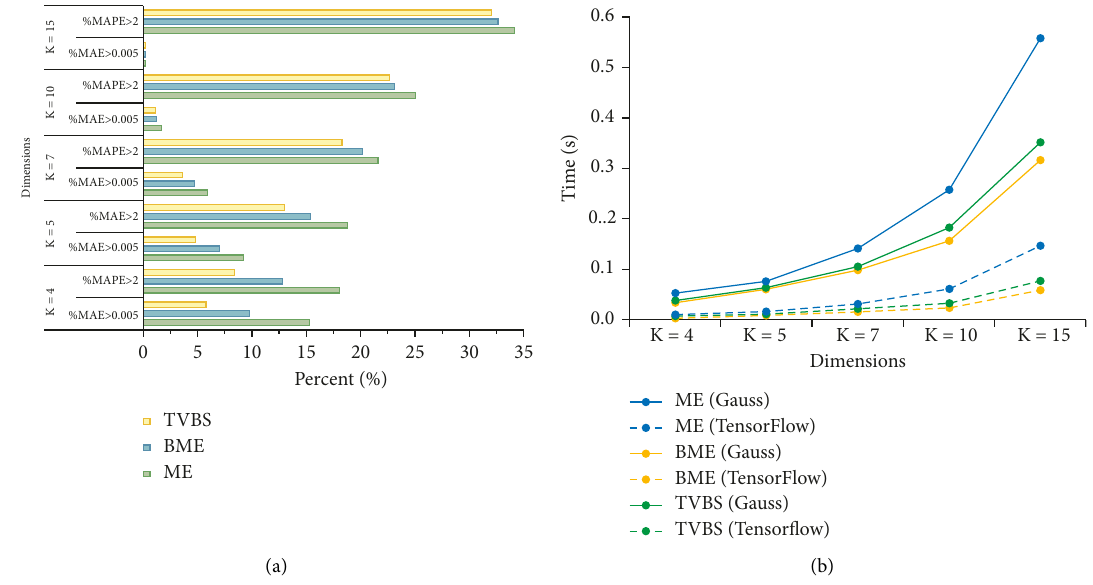
Figure 4: Comparison of accuracy and time with different dimensions. (a)